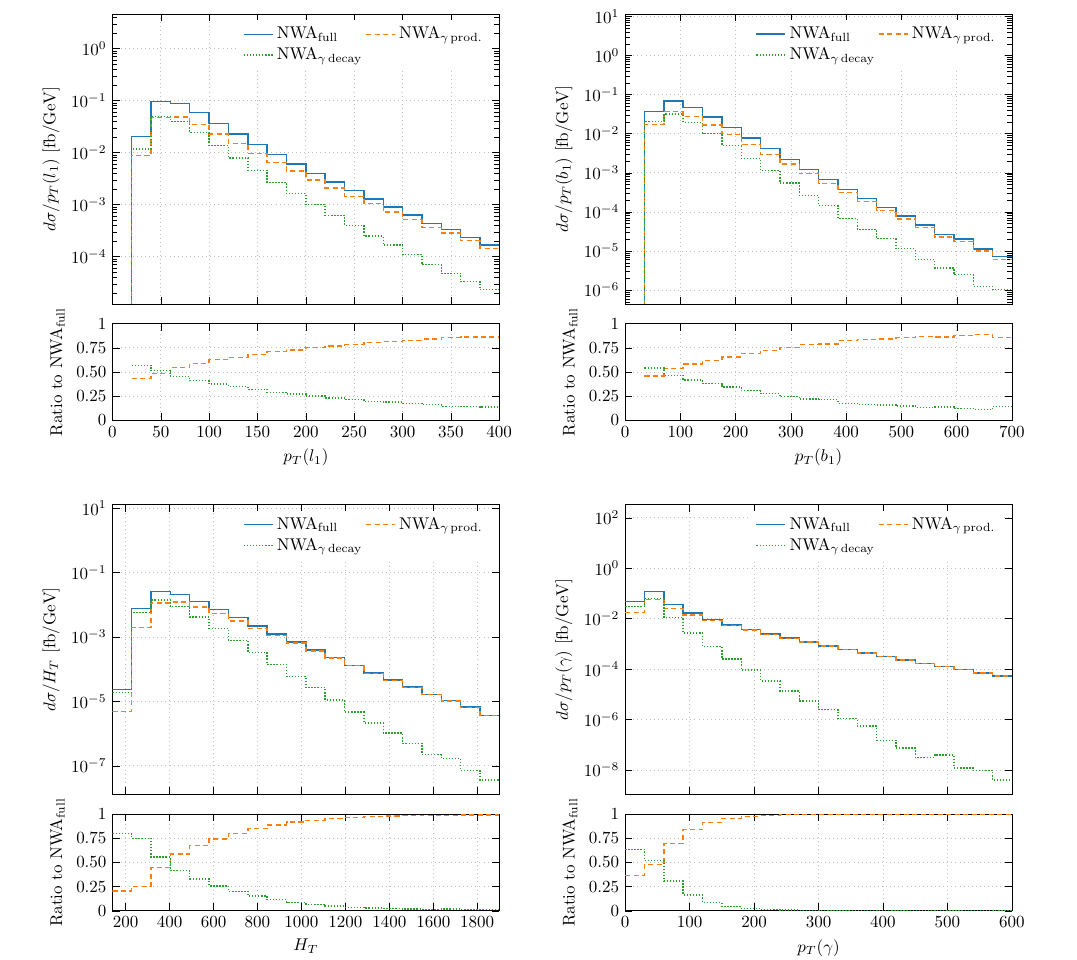
Figure 9 . The pp e + (cid:23) e (cid:22) (cid:0) (cid:22) (cid:23) (cid:22) b (cid:22) b(cid:13) di(cid:11)erential cross section distribution as a function of the ! transverse momentum of the hardest charged lepton, p T ( ‘ 1 ), and b -jet, p T ( b 1 ), the total transverse momentum of the e + (cid:23) e (cid:22) (cid:0) (cid:22) (cid:23) (cid:22) b (cid:22) b(cid:13) system, H T , and the transverse momentum of the isolated photon, p T ( (cid:13) ), at the LHC run II with p s = 13 TeV. The upper plots show absolute NLO QCD predictions in the full NWA together with fraction of events originating from photon radiation in the production, NWA (cid:13) prod , and in decays, NWA (cid:13) decay . The ratios of these contributions to the full NWA result are also shown. Results are given for (cid:22) 0 = H T = 4 and the CT14 PDF sets are employed.